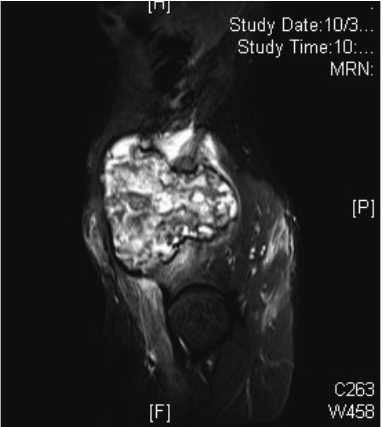
Figure 3: MRI T2W sagittal cuts showing dumbbell shaped mass present on either side of the right ilium.